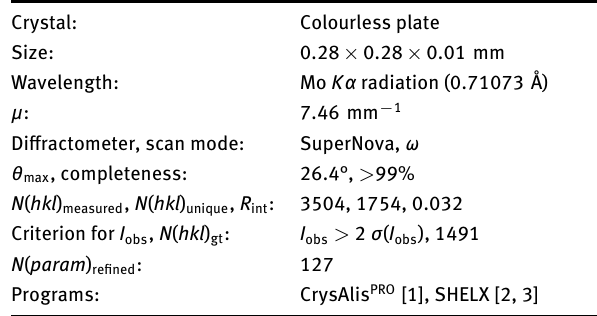
Table 2: Fractional atomic coordinates and isotropic or equivalent isotropic displacement parameters (Å 2